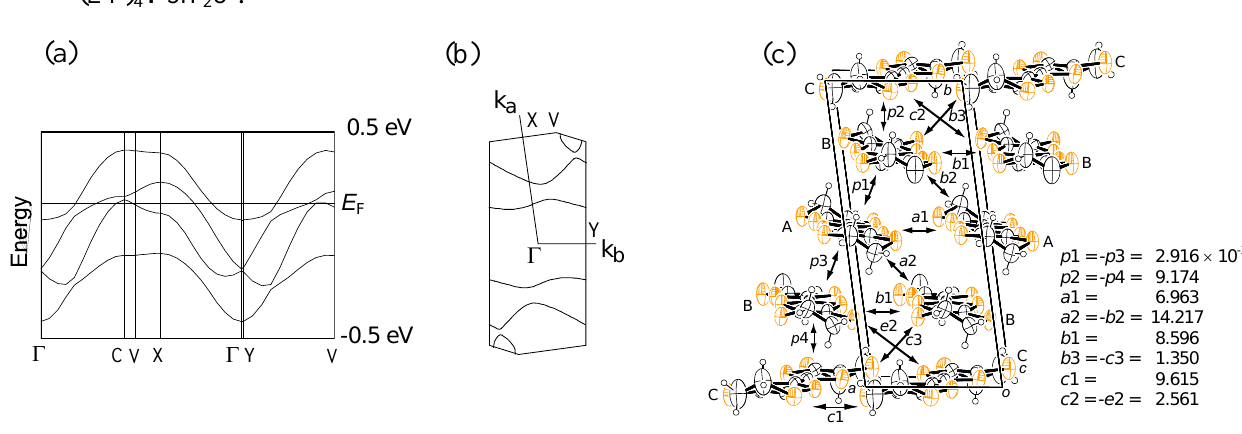
Figure 3. (a) Band dispersions, (b) Fermi surfaces and (c) transfer integrals of (ET) 1 ·3H 4 2